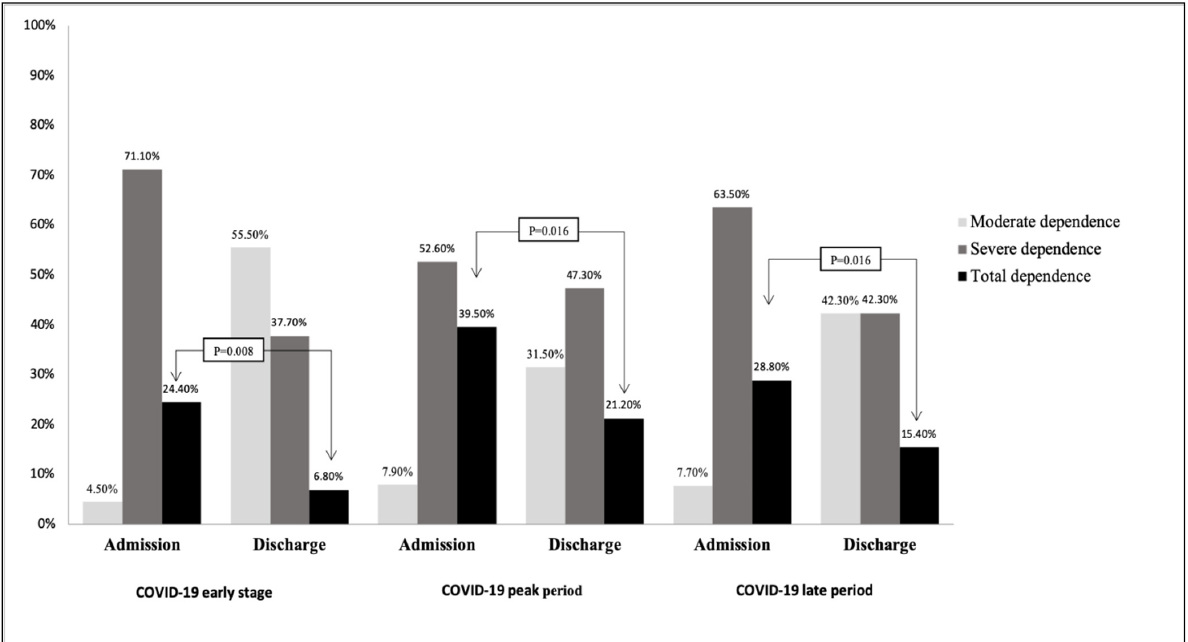
Figure 2. Activities of daily living at admission and discharge during the COVID-19 outbreak in Taiwan. Among the three periods, the number of patients who were totally dependent at admission was highest during the peak period and similarly at discharge. Compared to the number of patients who were totally dependent at admission, fewer patients were totally dependent at discharge, regardless of the period of the COVID-19 outbreak in Taiwan.